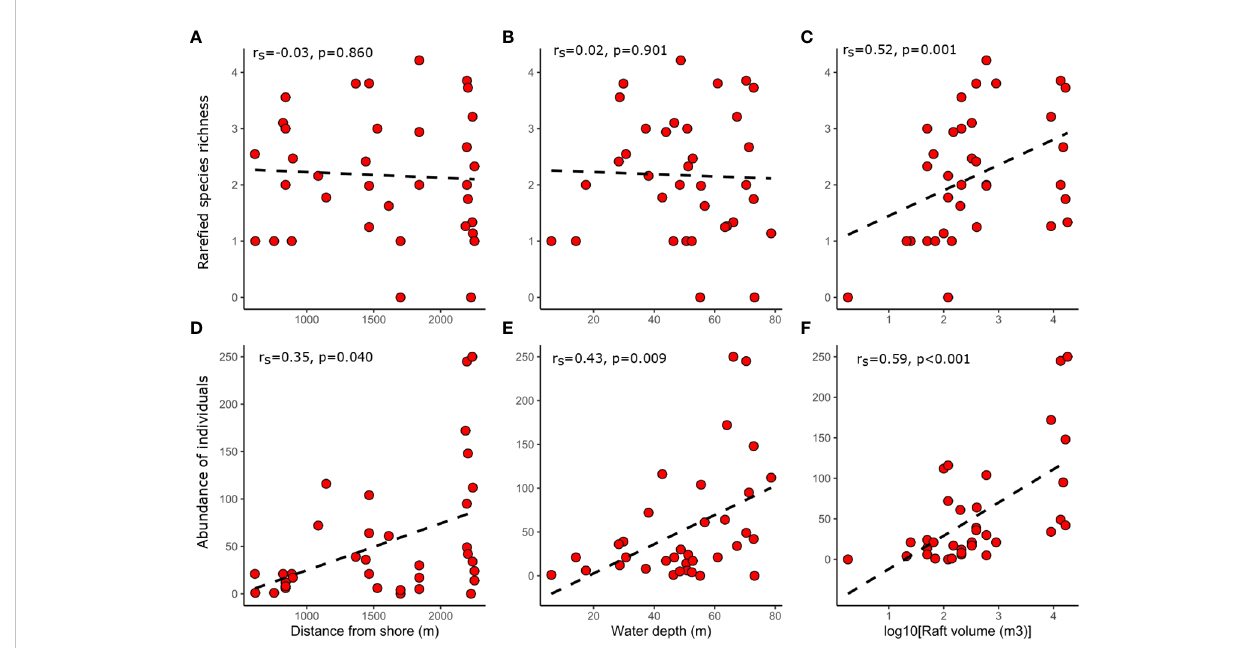
FIGURE 6 Scatter plots showing relationships between distance vs rare fi ed species richness (A) , water depth vs rare fi ed species richness (B) , raft volume vs rare fi ed species richness (C) , distance vs abundance of individuals (D) , water depth vs abundance of individuals (E) and raft volume vs abundance of individuals (F) . Spearman rank correlation coef fi cients and associated p-values are also shown. A best fi t line was inserted to help interpret